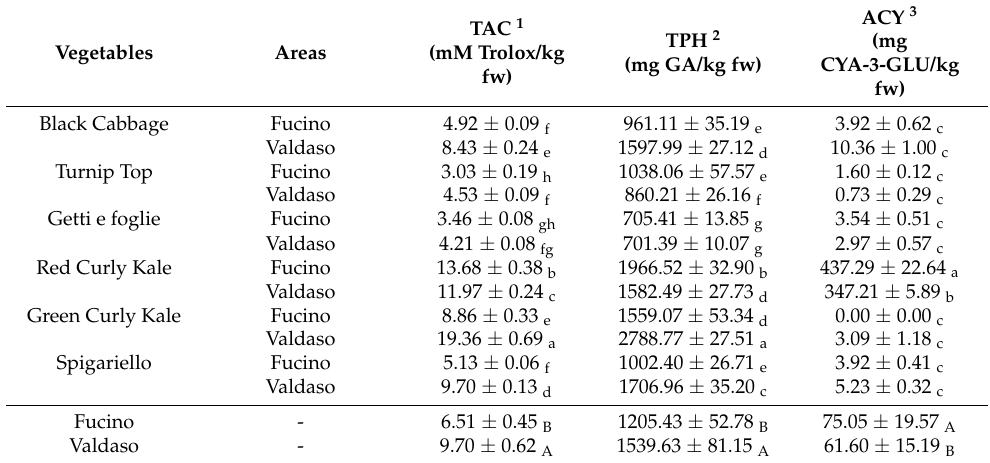
Table 9. Effect of vegetable genotype x environment interaction on 2nd year Valdaso and Fucino